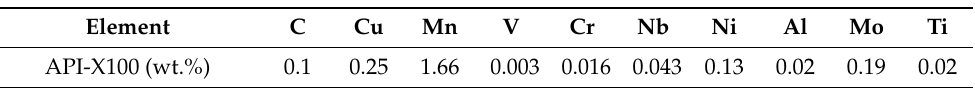
Table 1. Chemical composition (assay from the steel manufacturer) of the API-X100 pipeline steel samples (unit: